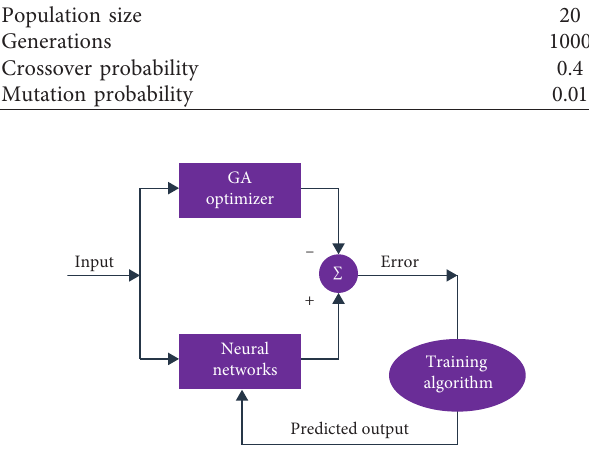
Figure 6: Proposed neural network model.